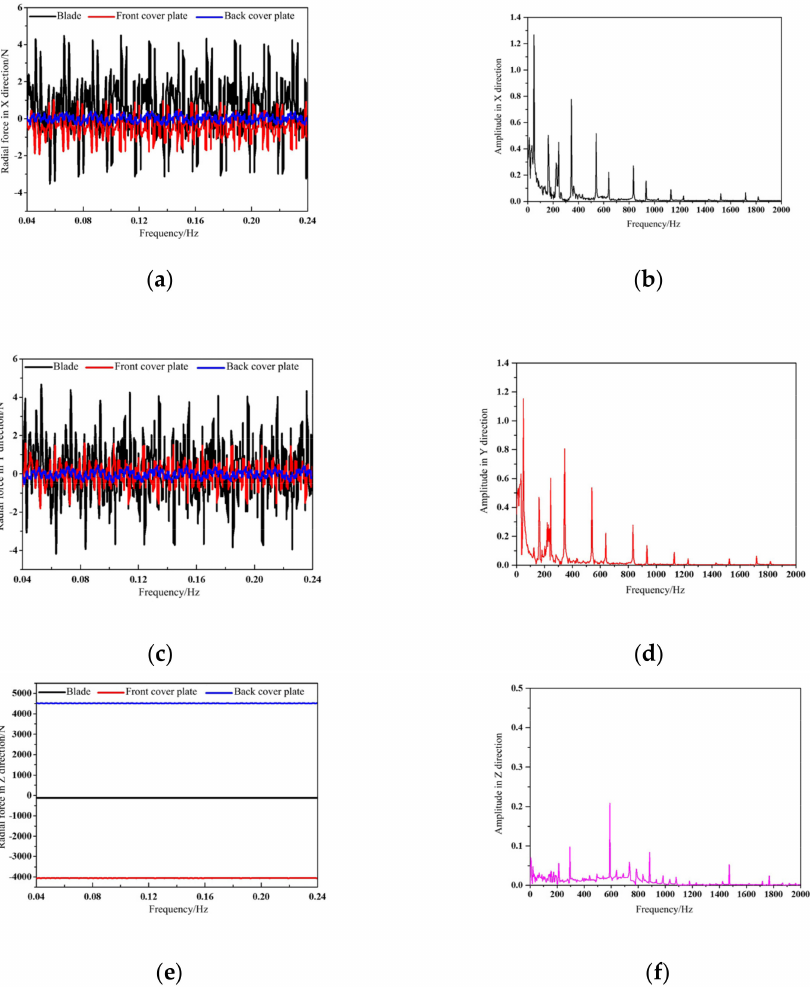
Figure 11. The radial force on each part of the impeller in the time domain and frequency domain: ( a ) time domain ( X ); ( b ) frequency domain ( X ); ( c ) time domain ( Y ); ( d ) frequency domain ( Y ); ( e ) time domain ( Z ); ( f ) frequency domain ( Z